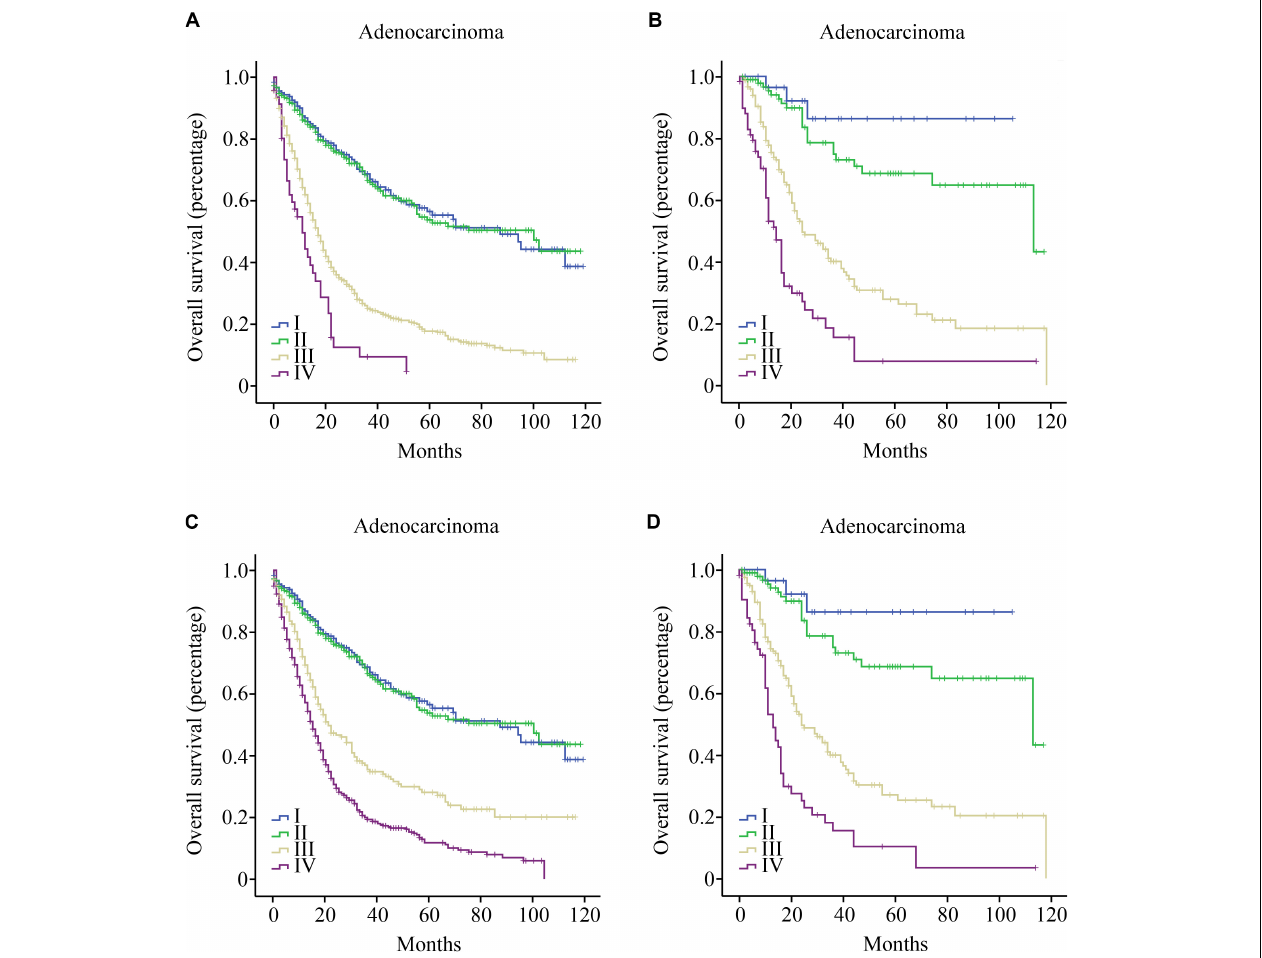
FIGURE 3 | Overall survival curves for patients with gallbladder adenocarcinoma by LN count; (A) Patients with fewer than six LNs examined according to the TNM staging system; (B) Patients with six or more LNs examined according to the TNM staging system; (C) Patients with fewer than six LNs examined according to the TNrM staging system; and (D) Patients with six or more LNs examined according to the TNrM staging system.